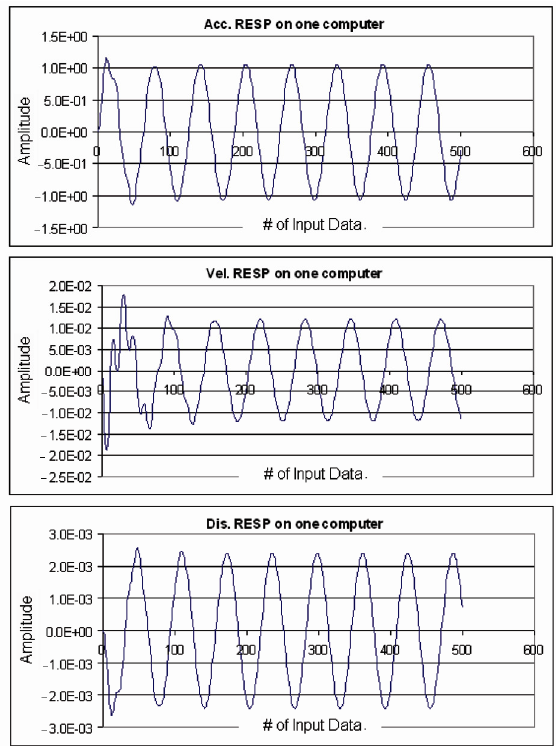
Fig. 5. Response of SDOF Structure from Computer 1